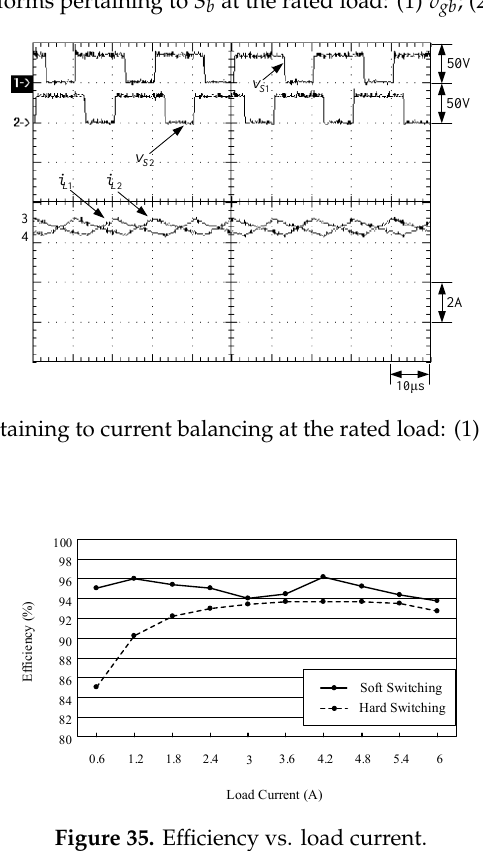
Figure 35. Efficiency vs. load current.